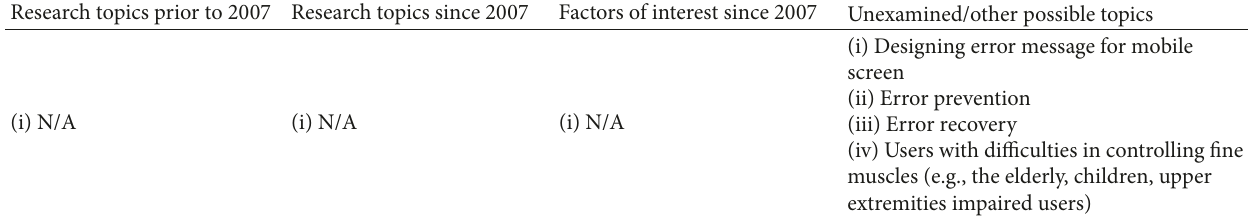
Table 6: Control and confirmation research.